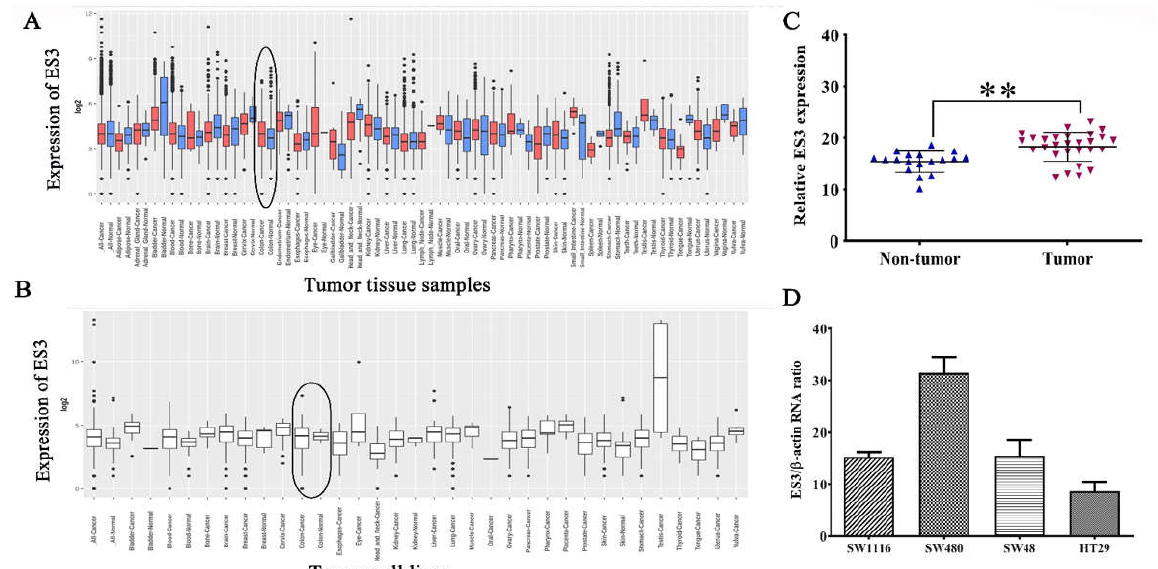
Fig. 1. LncRNA ES3 is expressed in widely various cancer cells and tissues: A) The expression analysis data which was obtained from TCGA data in GENT2 showed that ES3 transcript is expressed in widely various cancer tissues. The data suggested that the transcript may play an oncogenic role in numerous cancer types; B) ES3 expression level in different tumor cell lines which was derived from various cancers in TCGA database; C) RT-qPCR analysis of lncRNA ES3 expression indicated that its expression is significantly upregulated in CRC tissues rather than that in their corresponding colorectal normal tissues (**p < 0.01); D) The expression analysis data by RT- qPCR revealed that lncRNA ES3 is expressed in the four immortalized human CRC cell lines, while SW480 cells have the highest ES3 expression among them, and HT29 cells have the lowest level of ES3 expression.